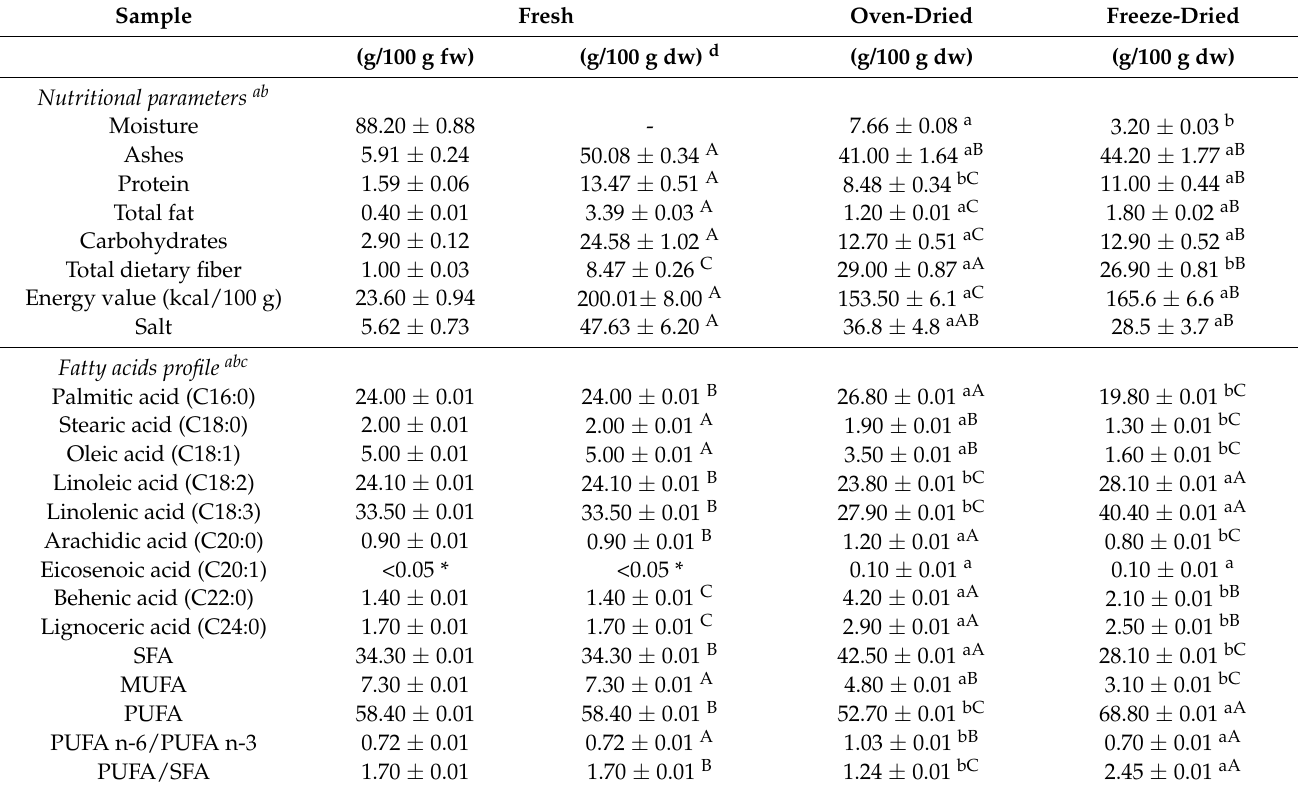
Table 1. Nutritional parameters and fatty acids of the fresh, oven, and freeze-dried S. ramosissima .